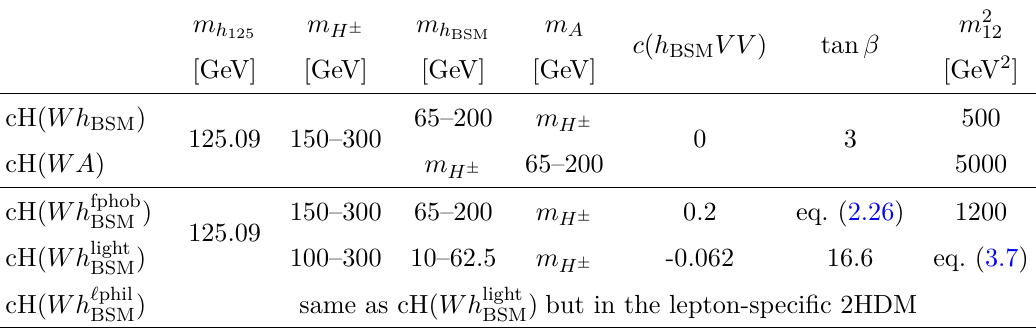
) are defined in the type I BSM